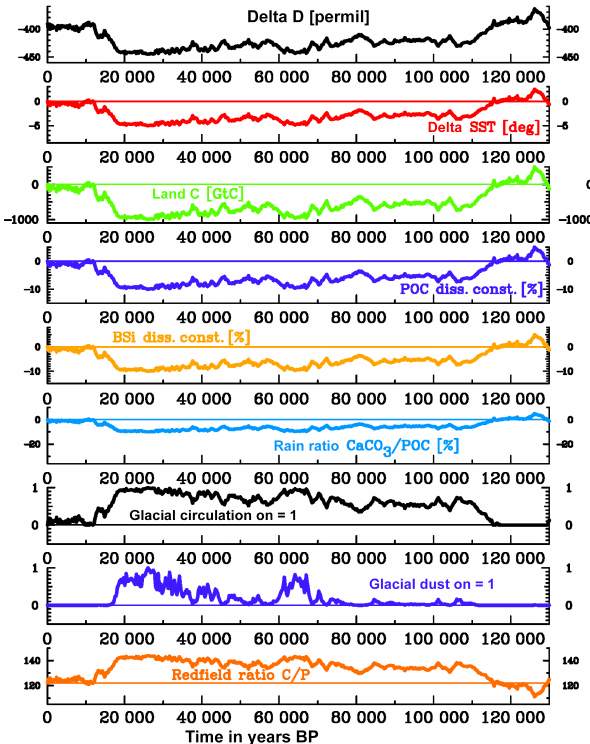
Figure 3. Prescribed parameter changes for the sensitivity experi- ments with the biogeochemical ocean